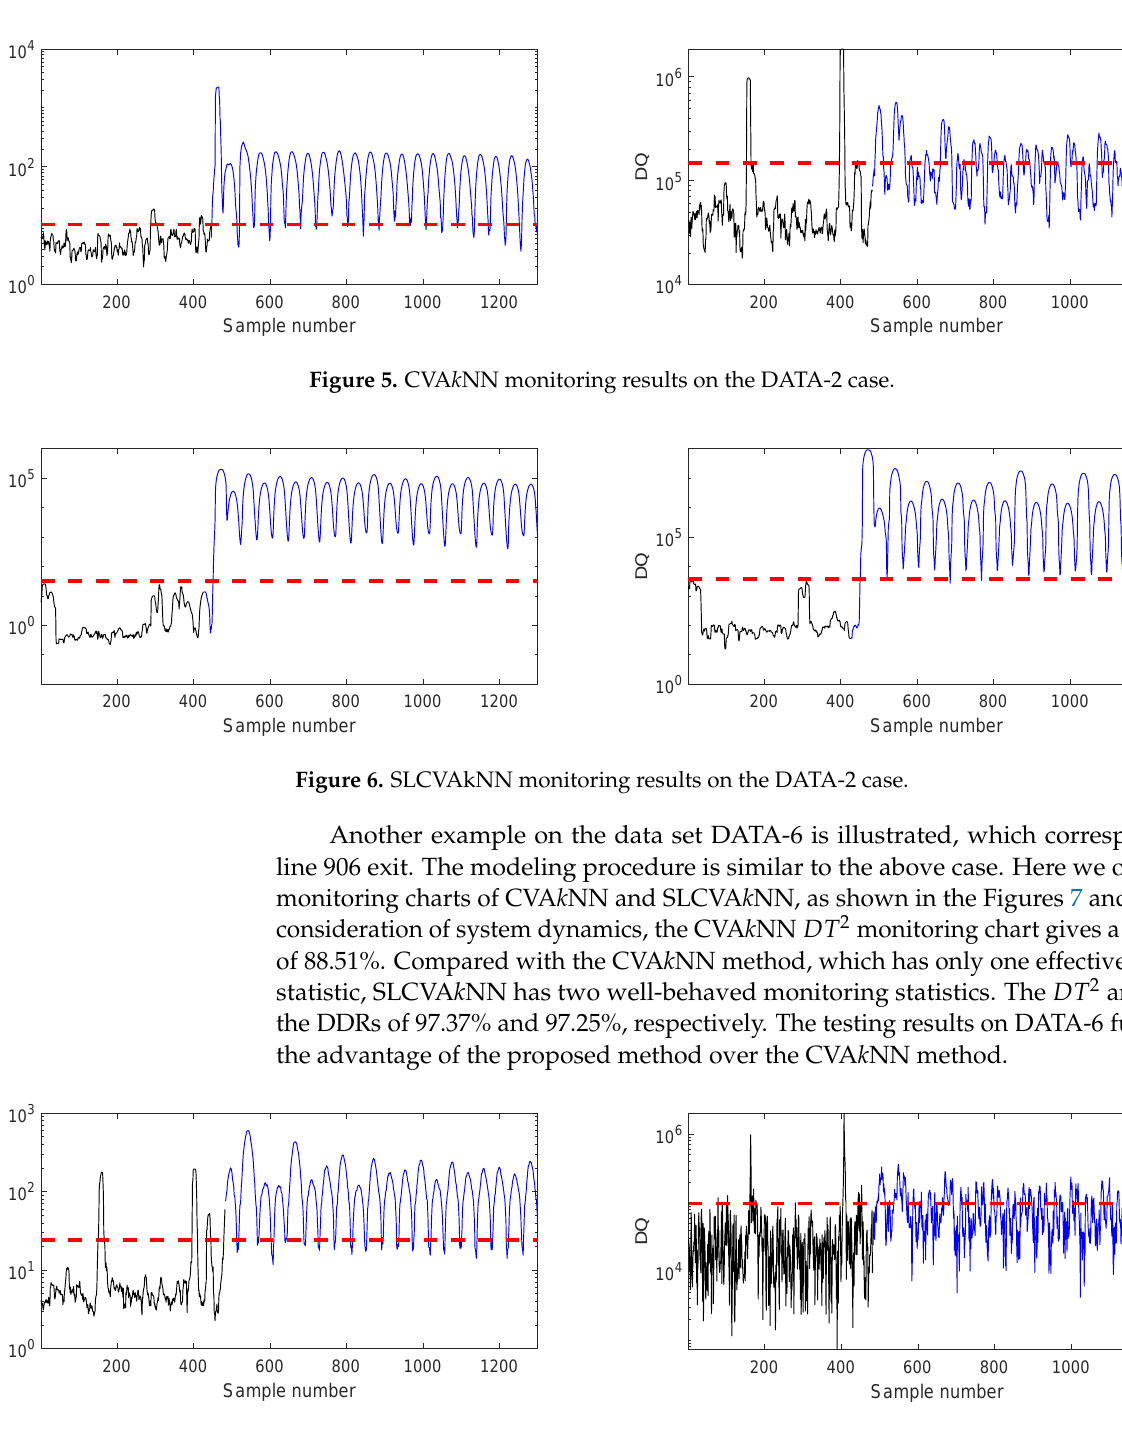
Figure 7. CVA k NN monitoring results on the DATA-6